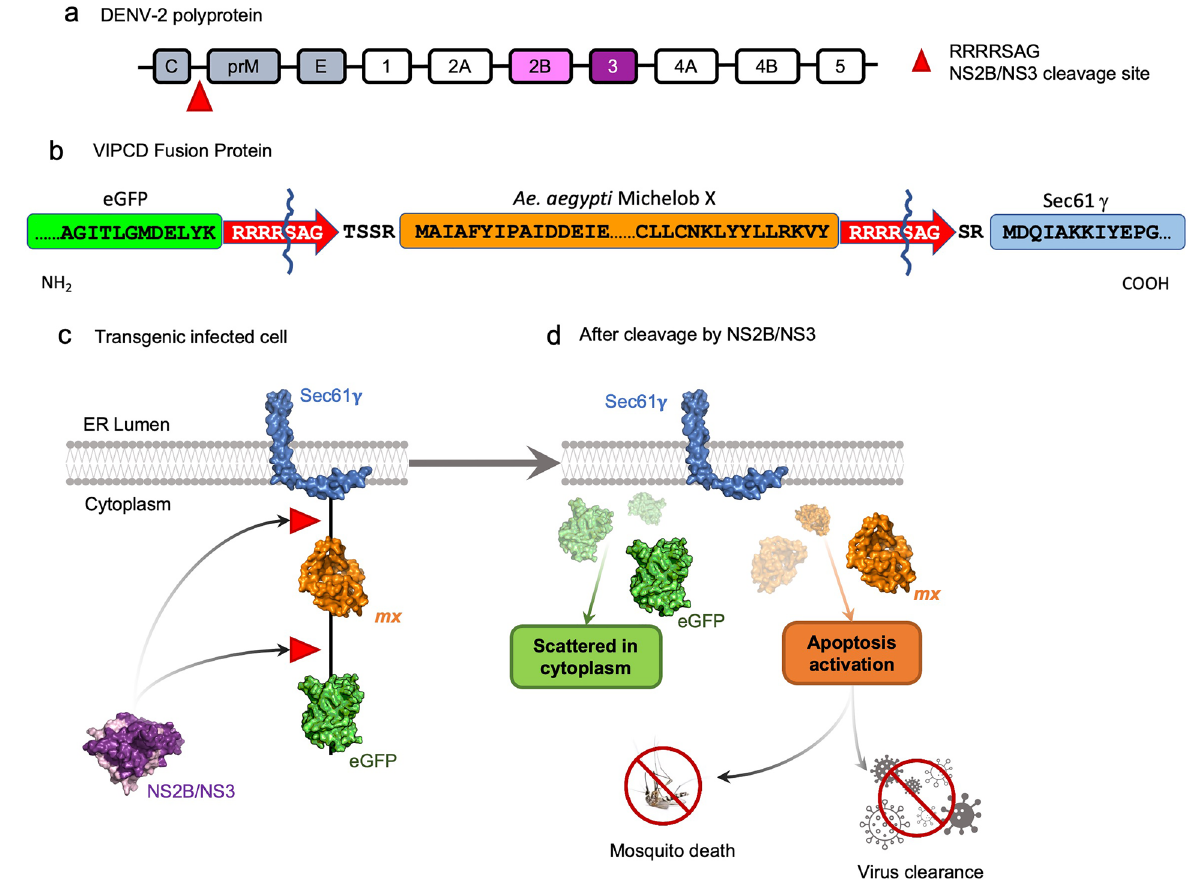
Figure 1. Genetic concept and mechanistic principle of the Virus Infection Promoting Cell Death (VIPCD) strategy. ( a ) General DENV polyprotein scheme showing the structural proteins C—Capsid; prM—Pre- membrane; E—Envelope; and nonstructural proteins NS1, NS2A, NS2B, NS3, NS4A, NS4B, NS5. The red triangle indicates the NS2B/NS3 cleavage site RRRRSAG releasing C (capsid) from the polypeptide of DENV- 2. ( b ) The transgenic VIPCD fusion protein design with eGFP (enhanced green fluorescent protein) as a fluorescent marker; Mx—michelob_x ORF (antagonist of the Inhibitor of Apoptosis); Sec61γ—gamma subunit of the Sec 61 complex as a transmembrane domain that anchors the peptide in the endoplasmic reticulum. Shown is the partial amino acid sequence of the fusion protein surrounding Ae. aegypti Michelob x and the flanking NS2B/NS3 cleavage motifs (RRRRSAG) to release the recombinant Mx in the presence of DENV-2 NS2B/NS3. The wavy line indicates the amino acid position where NS2B/NS3-mediated cleavage is occurring. ( c ) DENV-2 infection of cells harboring the VIPCD fusion protein anchored to the endoplasmic reticulum (ER) membrane with the fluorescence signal close to the nucleus and Mx initially inactive. ( d ) The VIPCD mechanism is triggered by the activation of the NS2B/NS3 protease. The protease cleaves the viral polyprotein as shown in ( a ) as well as the RRRRSAG amino acid motif in the VIPCD fusion protein thereby releasing eGFP and Mx into the cytoplasm. Release of recombinant Mx then triggers a chain of events leading to cell death resulting in mosquito mortality and/or specific elimination of infected cells, eventually blocking viral